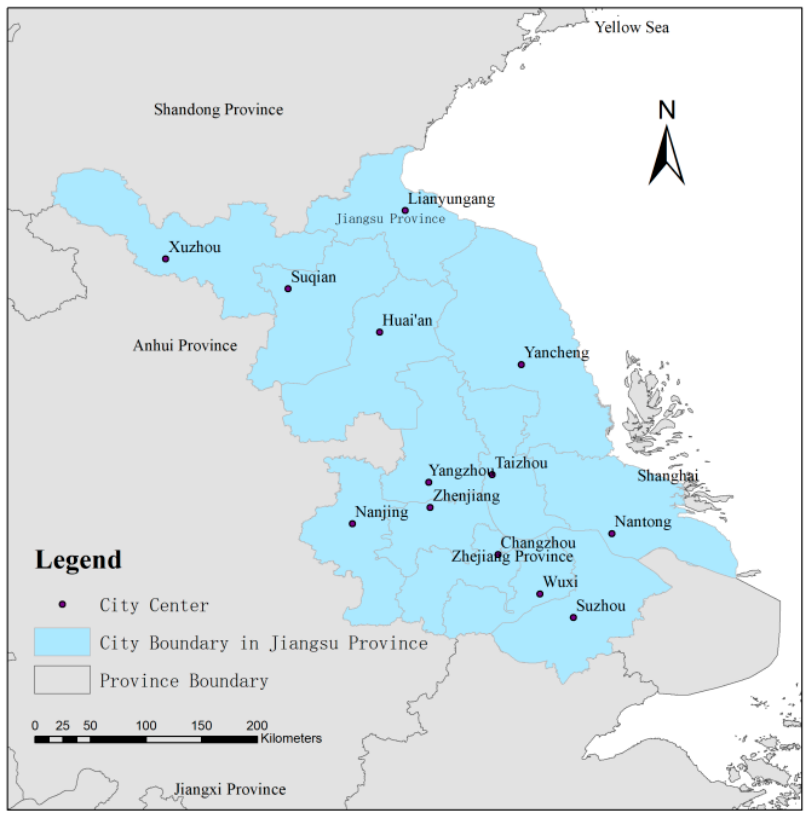
Figure 1. The geographical location of Jiangsu Province.